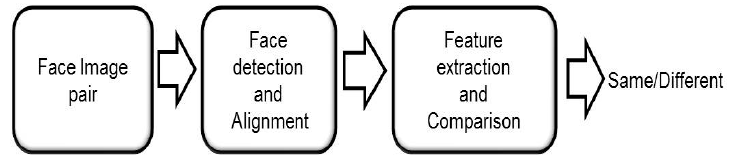
Figure 2. Face verification pipeline.